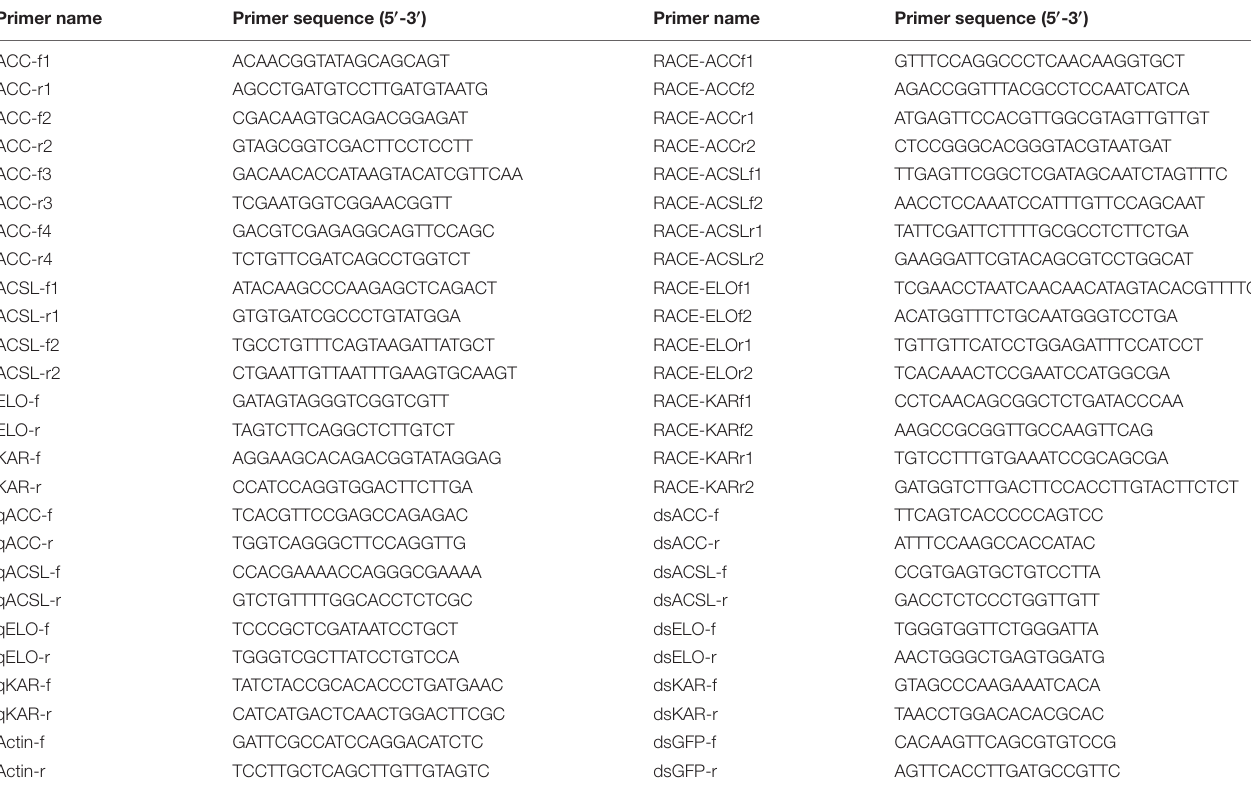
TABLE 1 | Primers used for gene cloning, qPCR and dsRNA